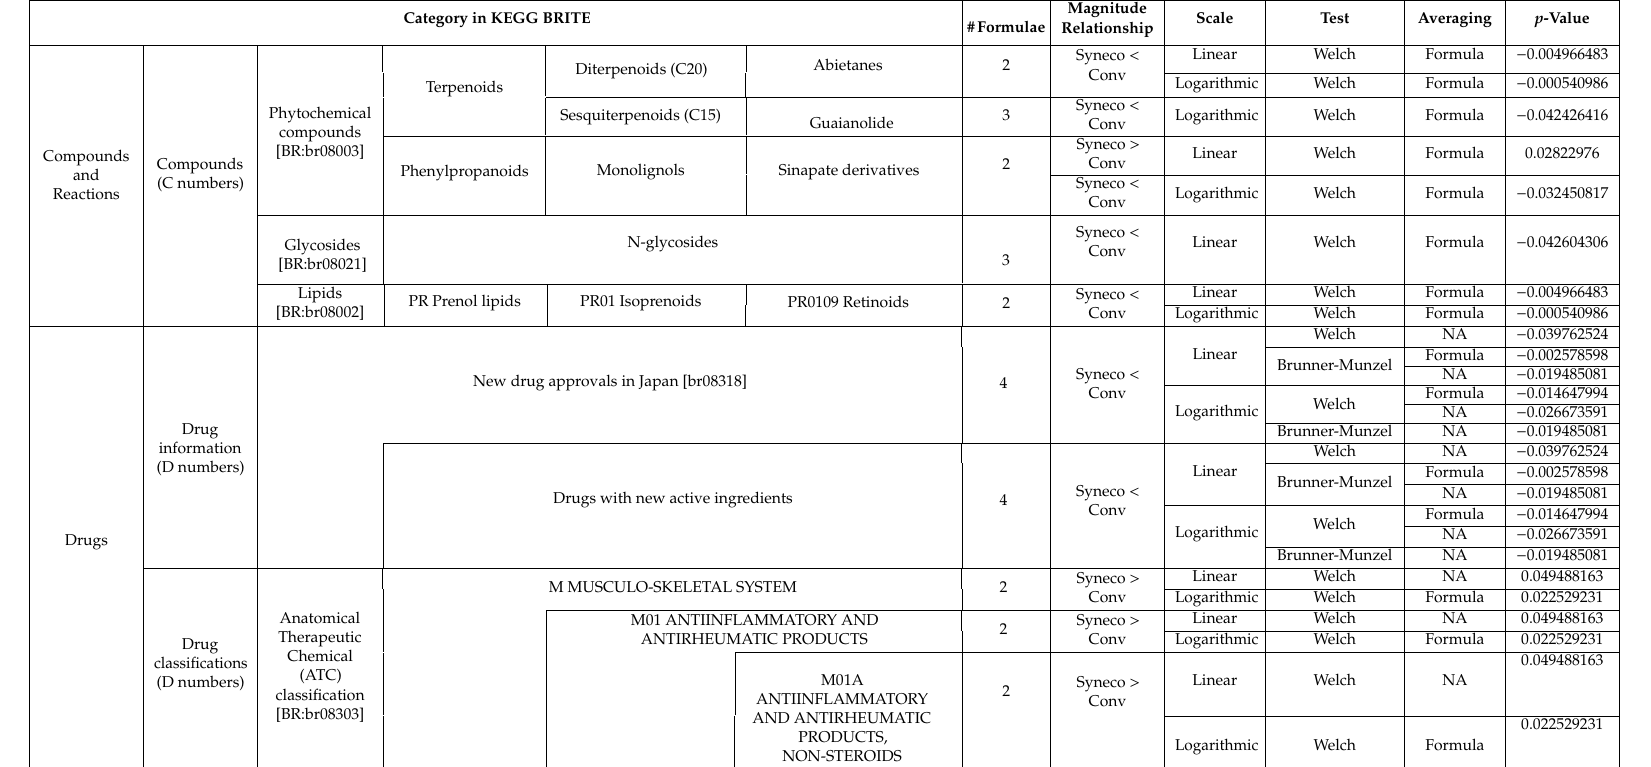
Table 5. Results of KEGG BRITE category-wise tests with p < 0.05: The di ff erence of intensity in each KEGG BRITE category (column “Category in KEGG BRITE”) is tested with two-sided Welch’s t -test and Brunner-Munzel test (“Test”). Other notations follow those of Table